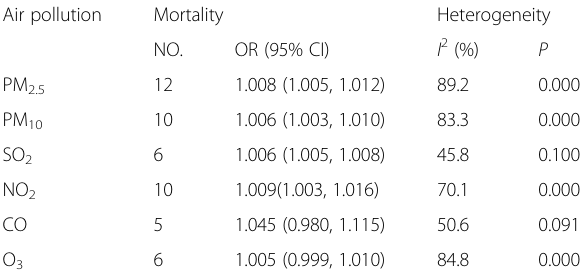
Table 4 Association between exposure to air pollution and stroke mortality (per 10 μ g/m 3 increment) Air